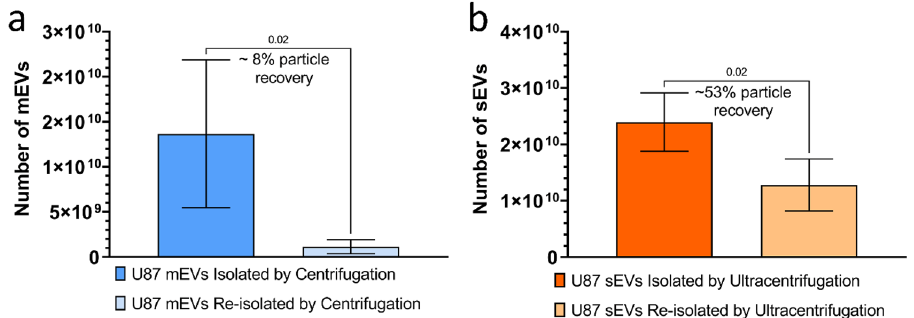
Figure 6. NTA quantification of EVs isolated and re-isolated by centrifugation. (a) U87 mEVs in 1× PBS were isolated by differential ultracentrifugation at 10,000× g and mEV particle yield calculated based on particle/ ml concentrations determined by ZetaView NTA. Following quantification of particle yield, known quantities of mEVs were re-isolated by differential ultracentrifugation at 10,000× g and % particle recovery determined. (b) U87 sEVs in 1× PBS were isolated by differential ultracentrifugation at 110,000× g and sEV particle yield calculated based on particle/ml concentrations determined by ZetaView NTA. Following quantification of particle yield, known quantities of sEVs were re-isolated by differential ultracentrifugation at 110,000× g and % particle recovery determined. Error bars = SD for n = 4 independent EV isolations., p values, determined by Student’s t-test are listed above drop-down lines. p values < 0.05 were considered statistically significant.